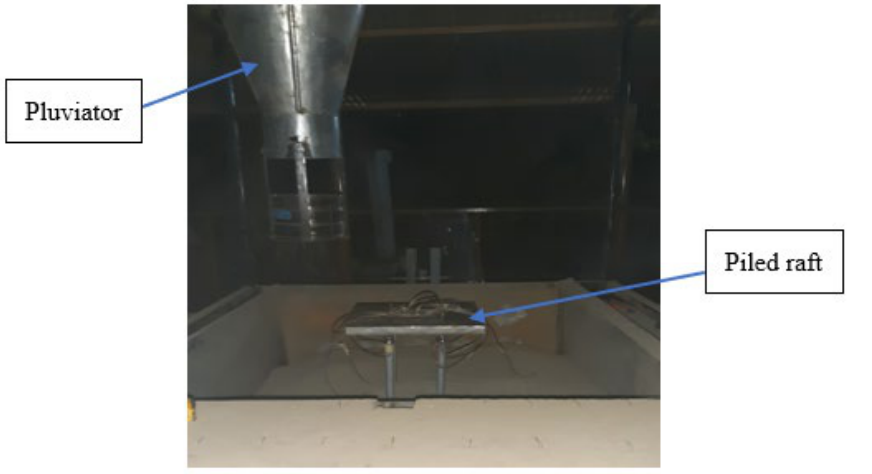
Figure 7. Piled raft model placement during air pluviation.